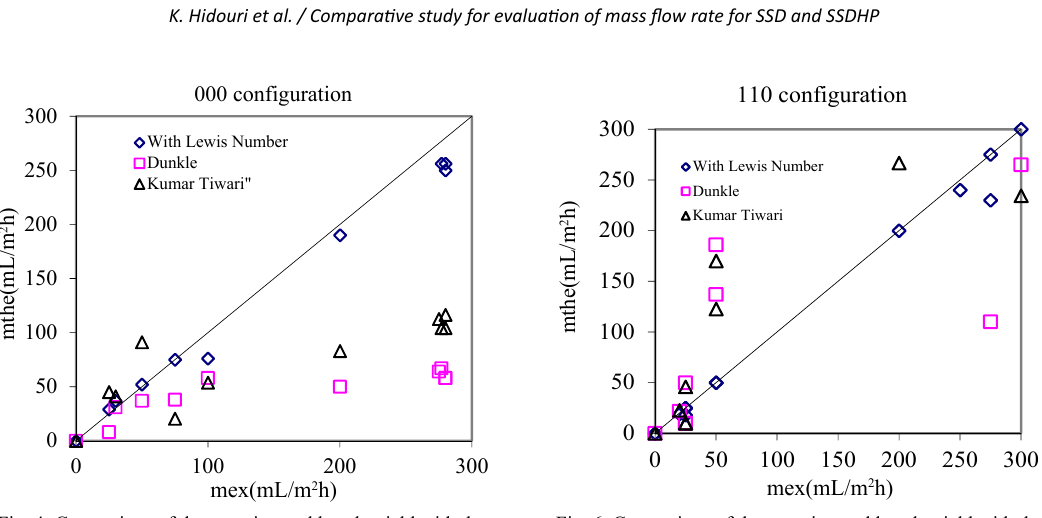
Fig. 4: Comparison of the experimental hourly yield with that obtained by Dunkle, Kumar and Tiwari and Lewis number correlations in SSD model (000 configuration).